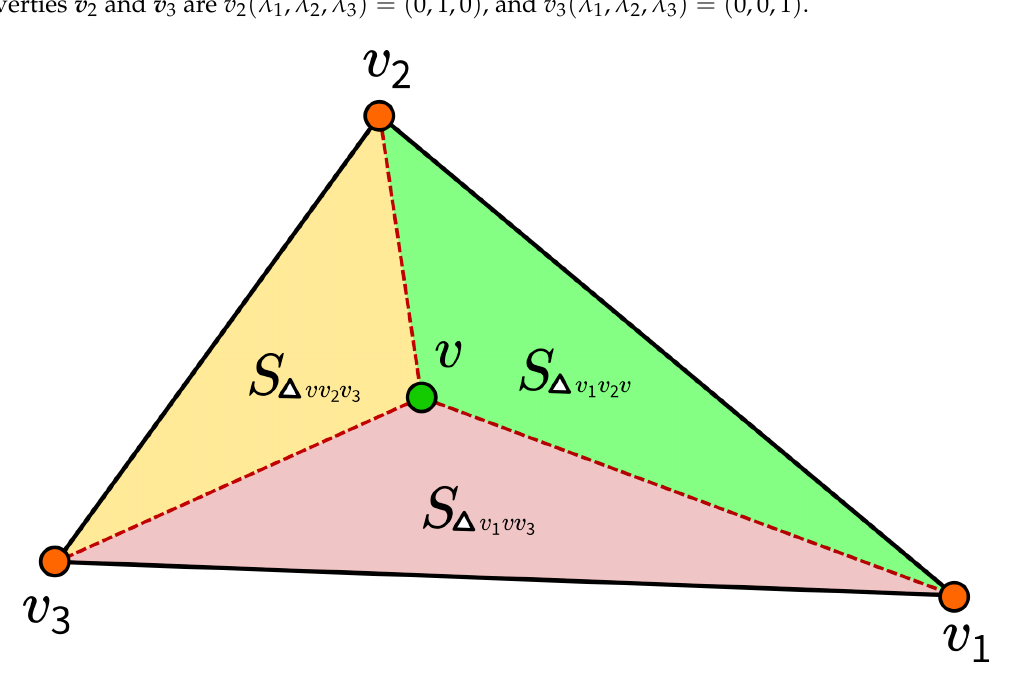
Figure 5. Barycentric coordinates (in the case of planar